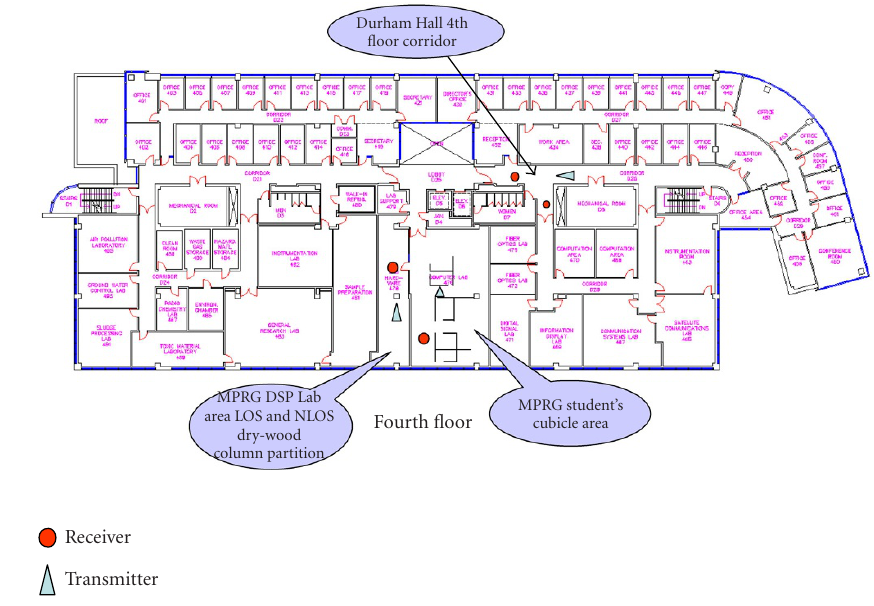
Figure 10: Floor plan of the fourth floor of Durham Hall.